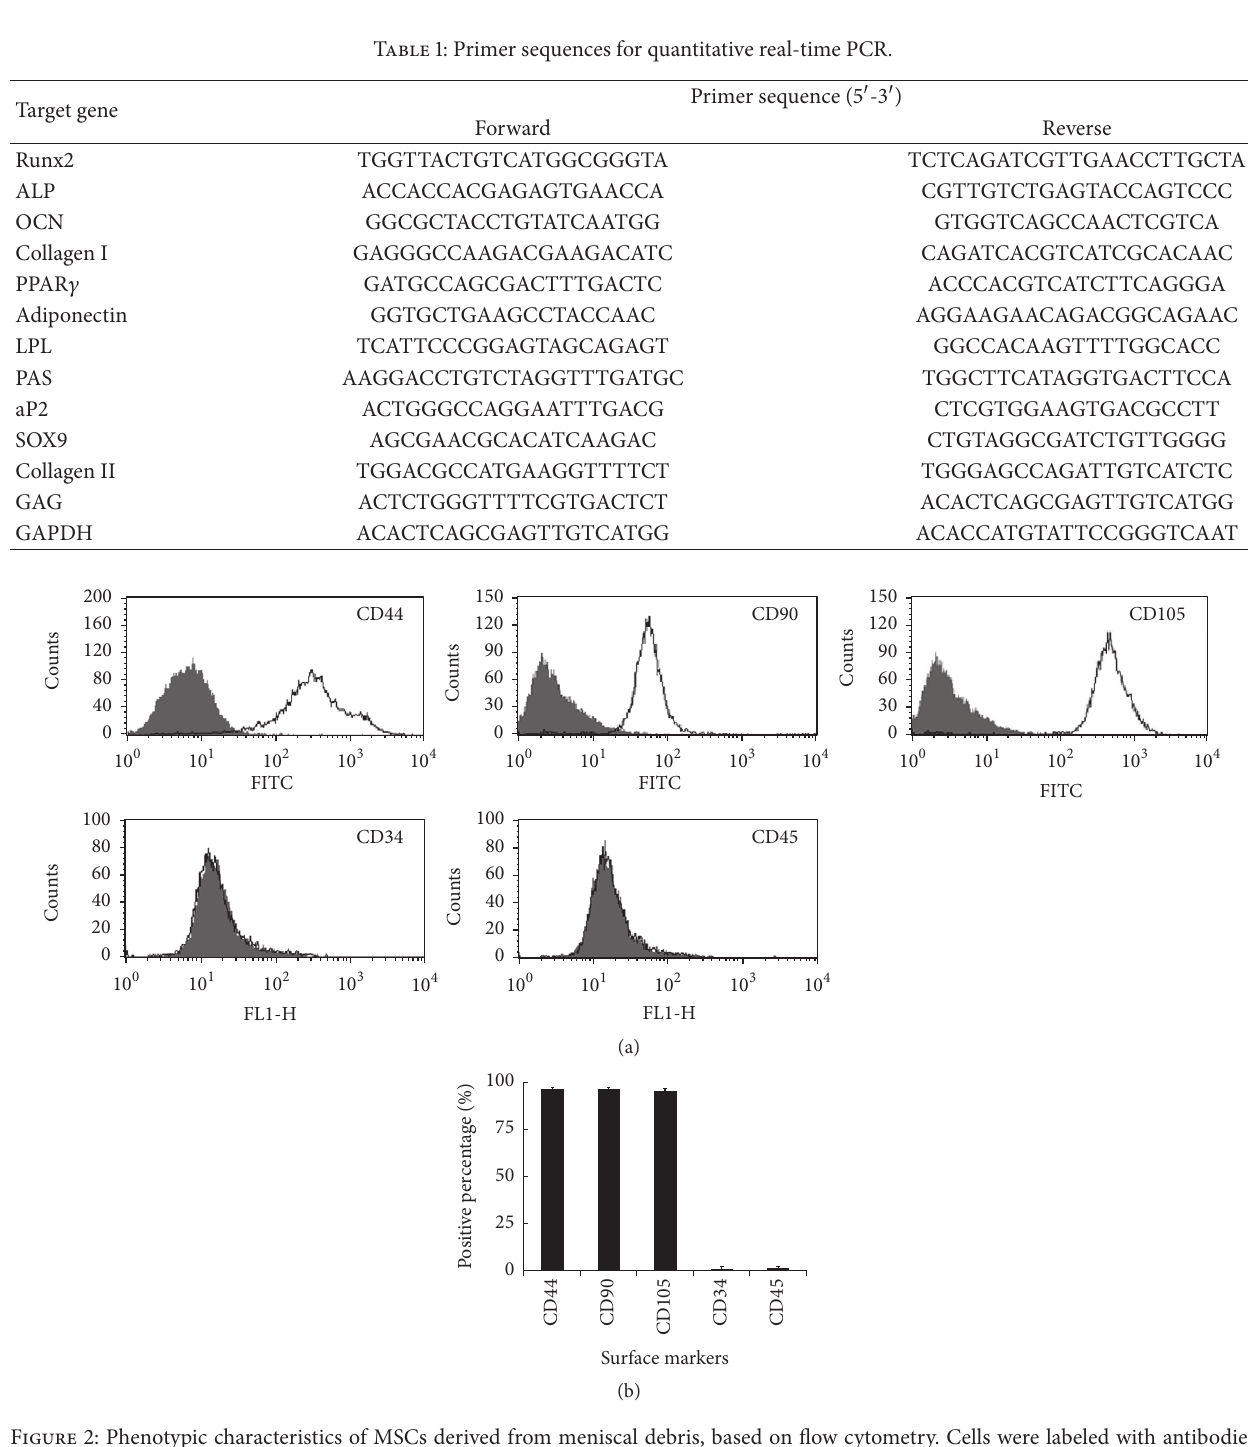
Figure 2: Phenotypic characteristics of MSCs derived from meniscal debris, based on flow cytometry. Cells were labeled with antibodies against CD44, CD90, CD105, CD34, and CD45. The black lines correspond to fluorescence intensity of anti-marker antibodies, while grey areas correspond to nonspecific anti-mouse IgG as an isotype control (a). Data are presented as mean ± SD